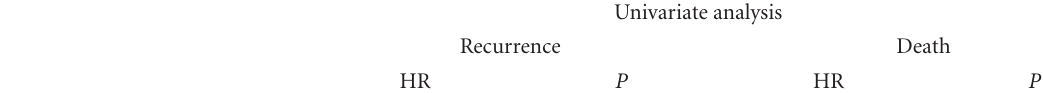
Table 4: Clinicopathologic features of the patients included in the TMA analysis.